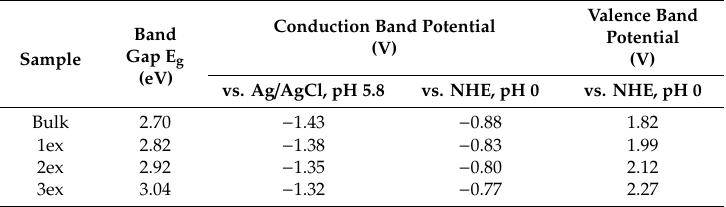
Table 3. Gap energy and potentials of the conduction and the valence